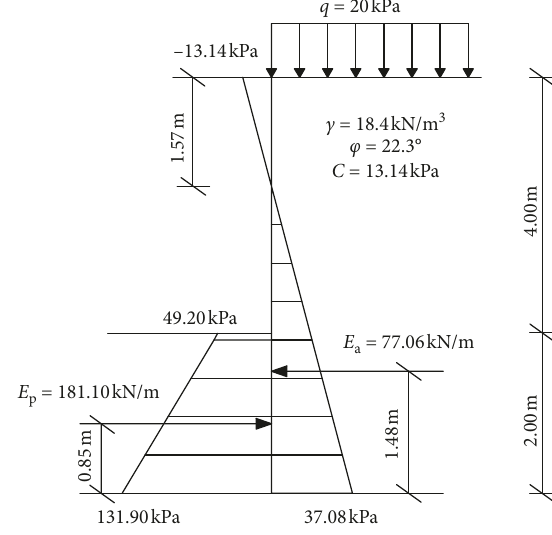
Figure 2: Distribution of earth